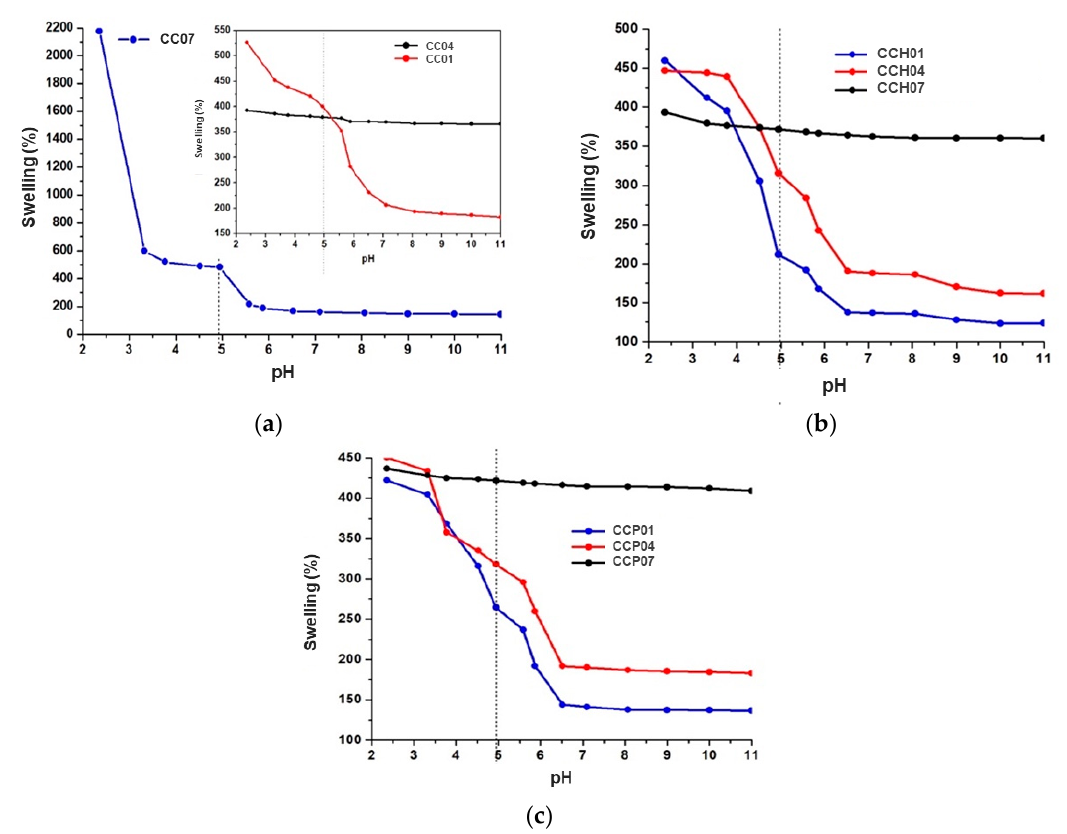
Figure 4. Critical pH value of different systems: ( a ) CC01, CC04, and CC07 copolymers; ( b ) CCH01, CCH04, and CCH07 nanocomposites modified with HDTMA; ( c ) CCP01, CCP04, and CCP07 nanocomposites modified with PTMA.